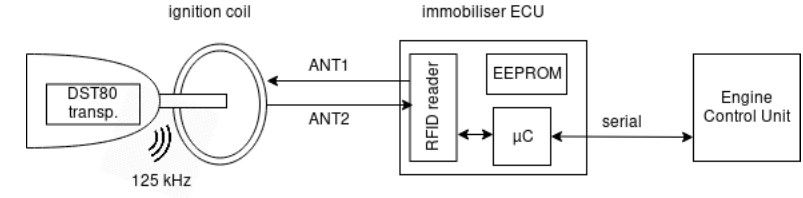
Figure 1: A typical immobiliser